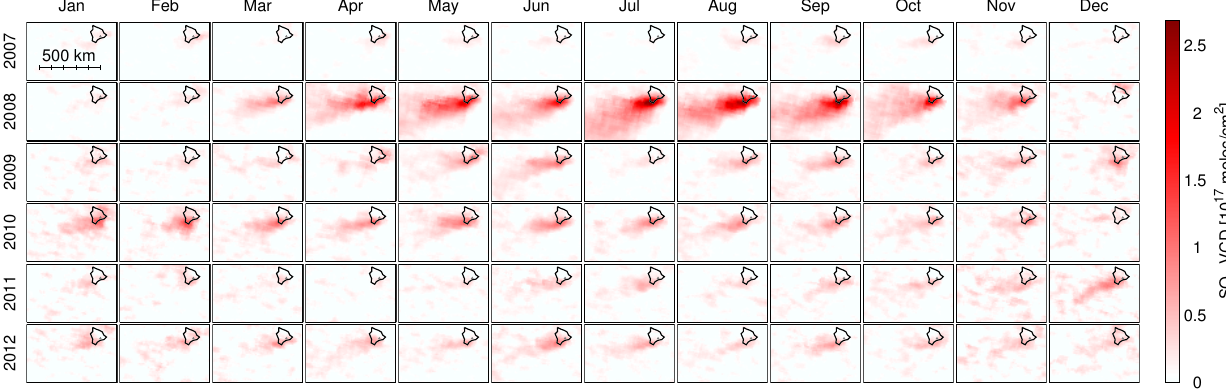
Figure 1. Monthly mean SO 2 VCD 2007–2012. The upper end of the color scale corresponds to 10DU. Each panel covers 161–154 ◦ W longitude and 16–20.5 ◦ N latitude (compare Fig. 2).